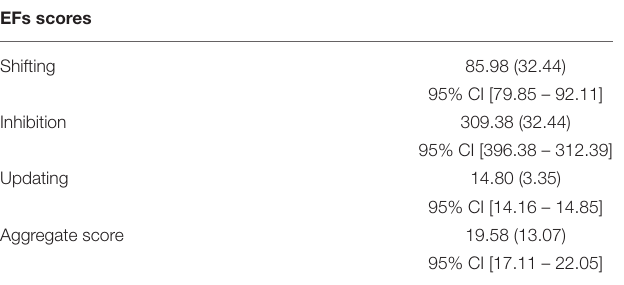
TABLE 1 | Table shows the mean reported by participants at the three EF (i.e., Shifting, Inhibition, and Updating) tasks and the aggregate score of EFs.